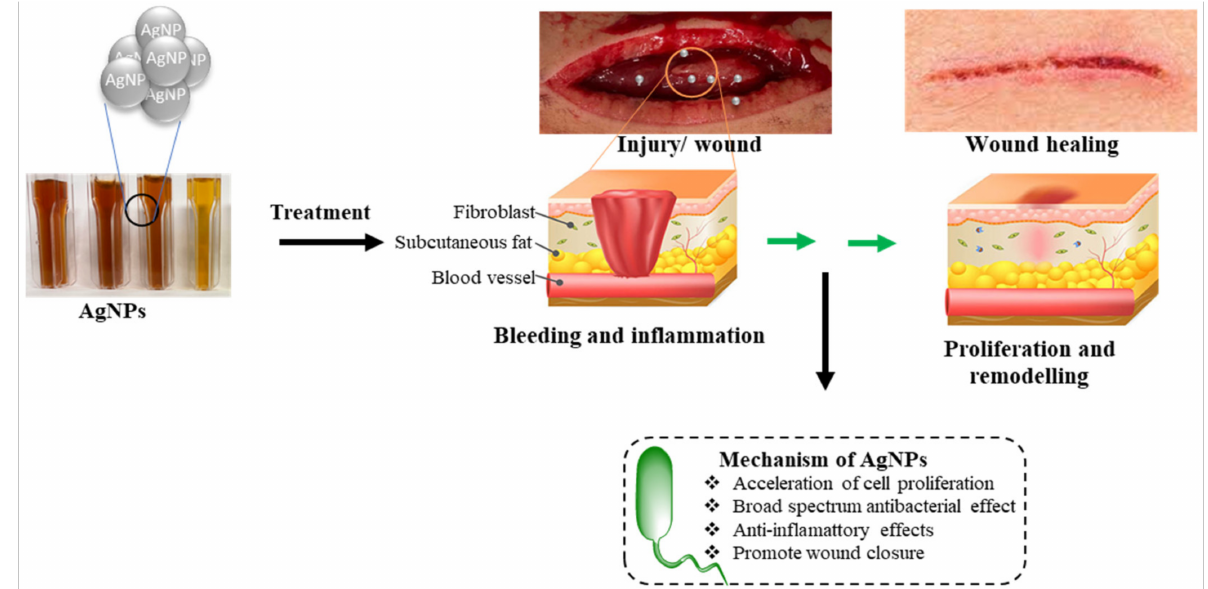
Figure 3. AgNP wound-healing mechanism. Exposure to AgNPs promotes wound closure by preventing bacterial colonisation and inflammation in the wound site. Open wound image adapted from